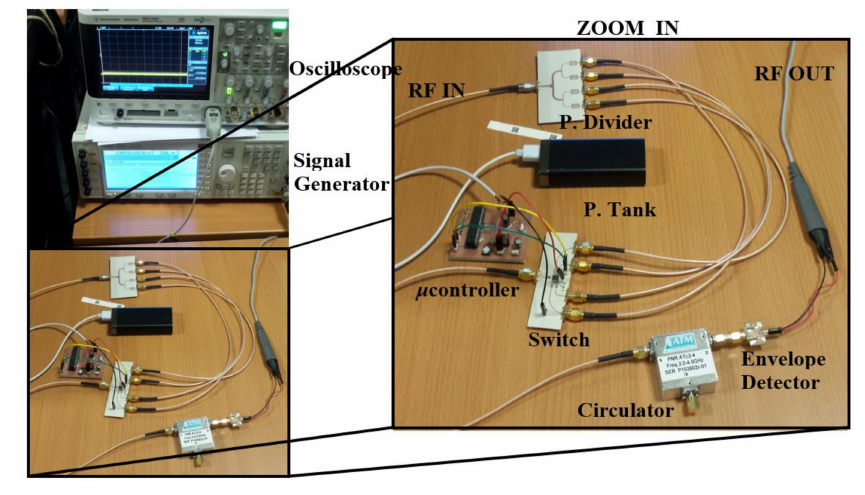
Figure 8. Photograph of the chipless setup, where all components are shown.